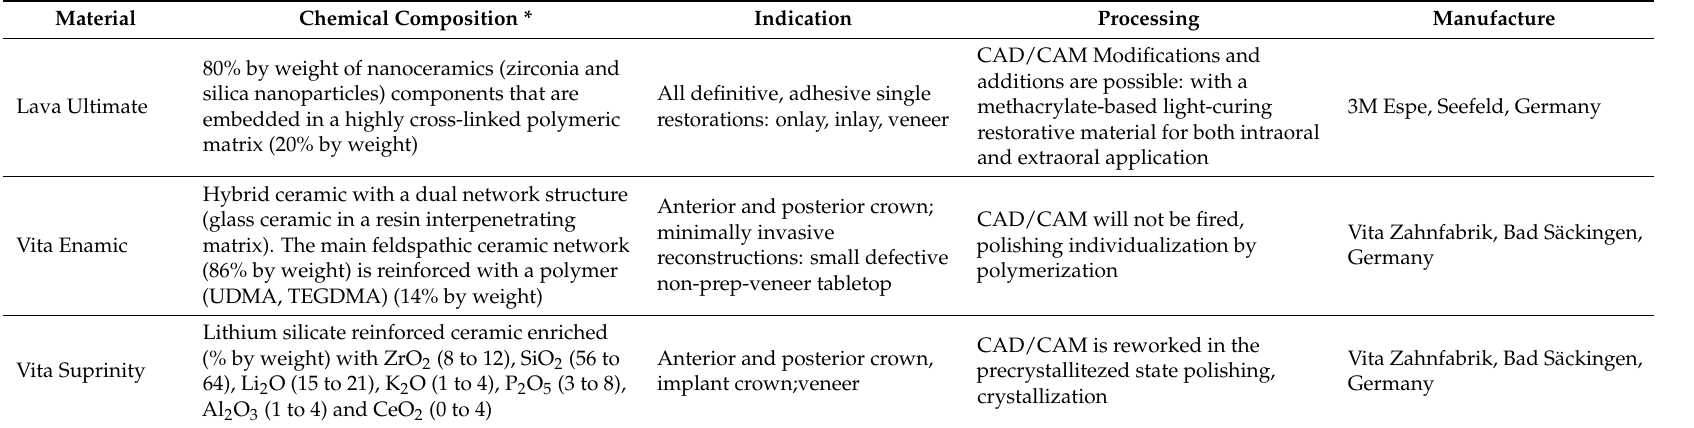
Table 7. Description of the full crown materials used in this